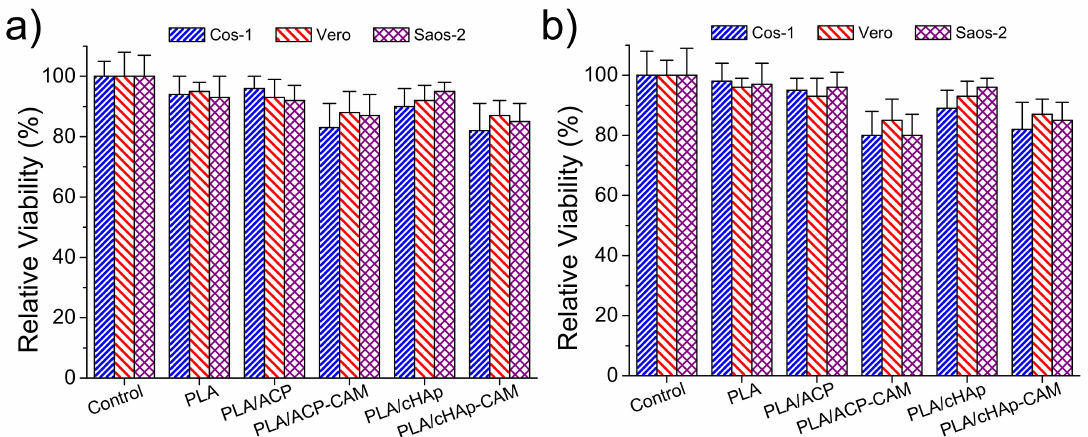
Figure 13. Relative viability for adhesion ( a ) and proliferation experiments for COS-1 (blue), VERO (red) and SAOS-2 (lilac) cells in the control and the indicated sca ff olds. Significant di ff erences ( p < 0.05 level) were not observed from statistical